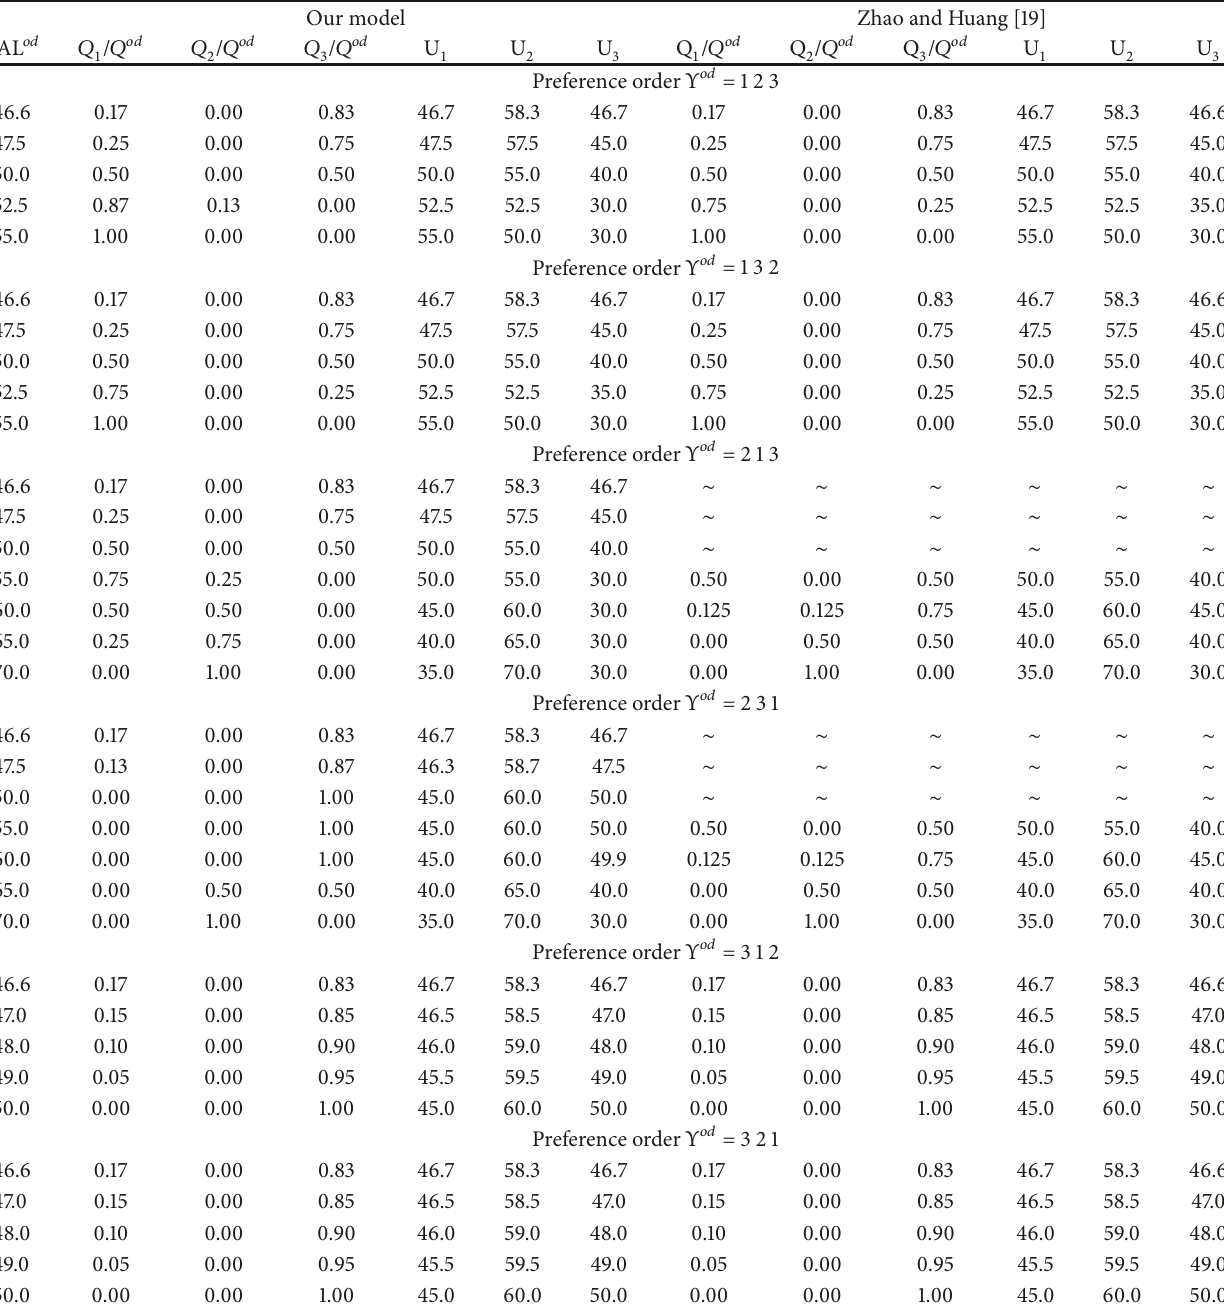
Table4:RouteflowdistributionfortheBraessnetworkfordifferentvaluesofthe 𝐴𝐿 andunderBR-DUEconditions.Asetofstrictpreferences is considered for the search